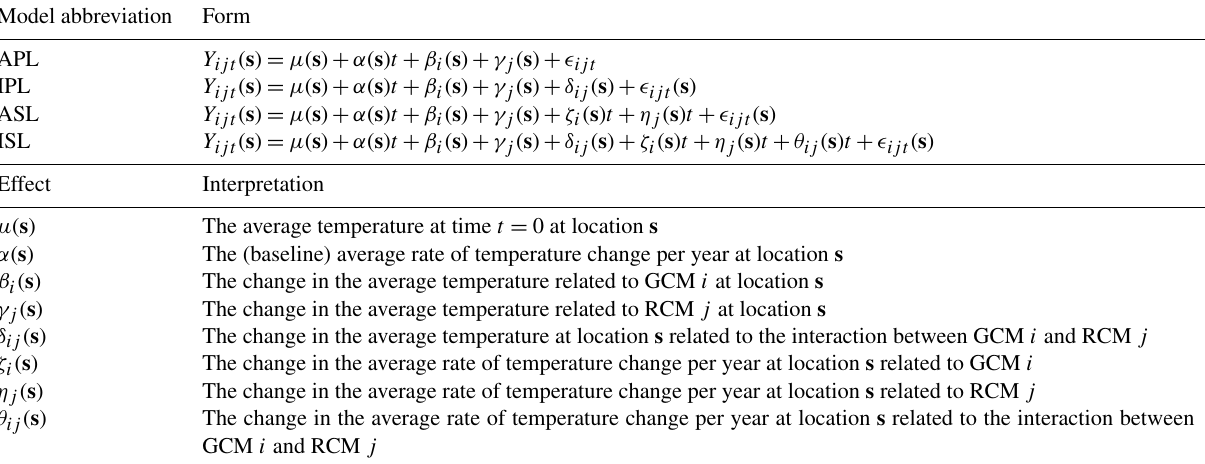
Table 3. A summary of the regression model classes considered, as well as the interpretation of the various model effects. Model abbreviation